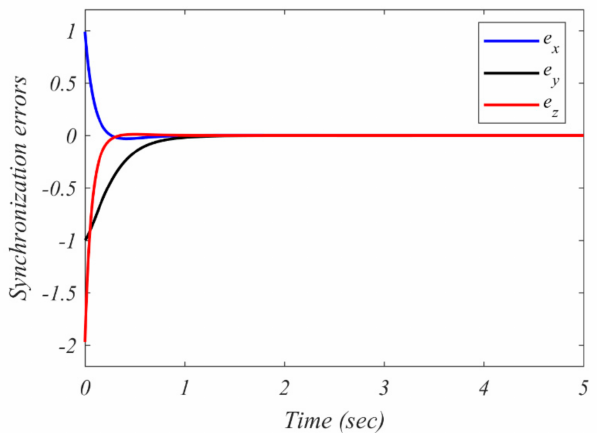
Figure 8. The state variables synchronization